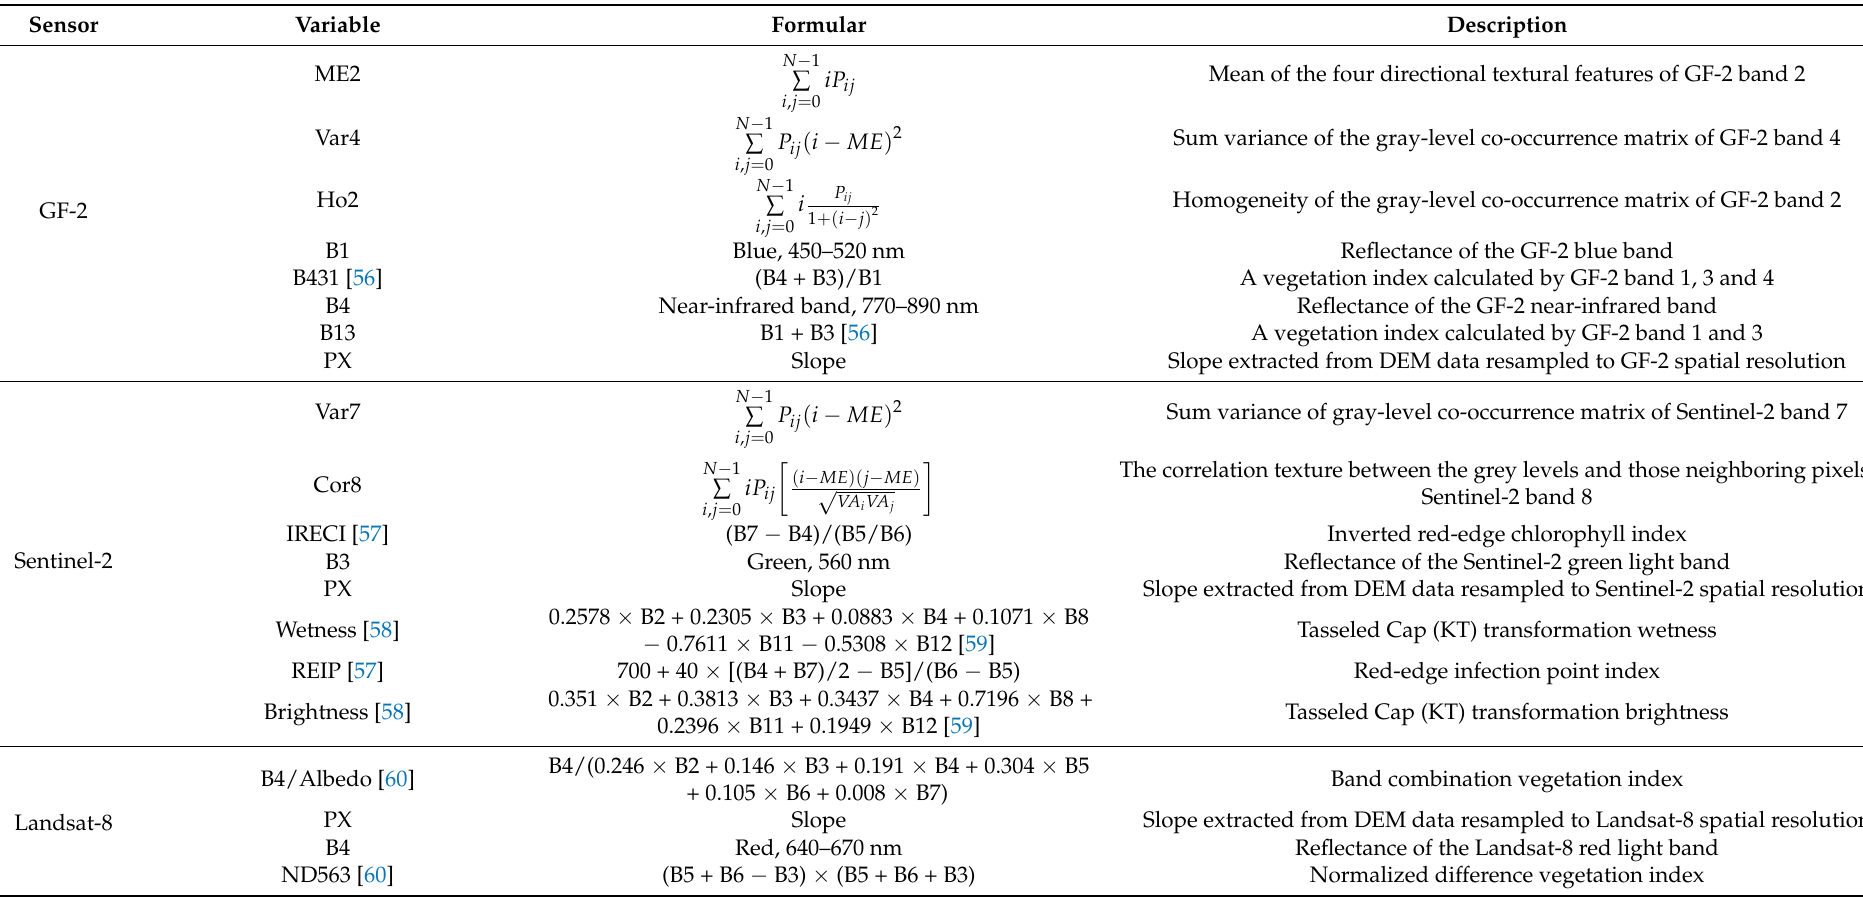
Table 2. Selected variables for AGB